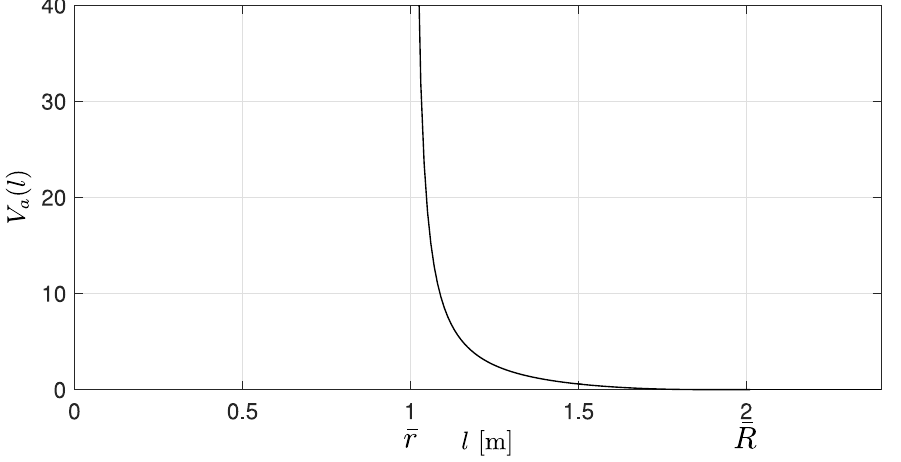
Figure 1. An example of APF (indexes omitted for simplicity).